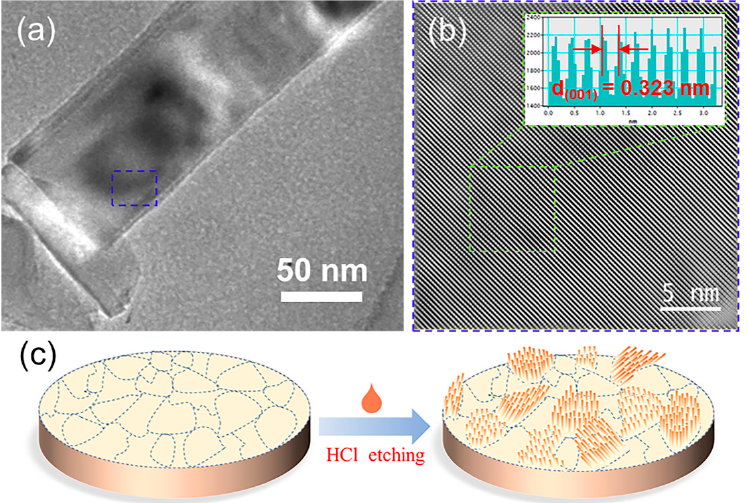
Figure 6. ( a ) The TEM image of TiB 2 nanorod, ( b ) the HRTEM image of TiB 2 needle, ( c ) schematic diagram of sample surface morphology before and after HCl etched.